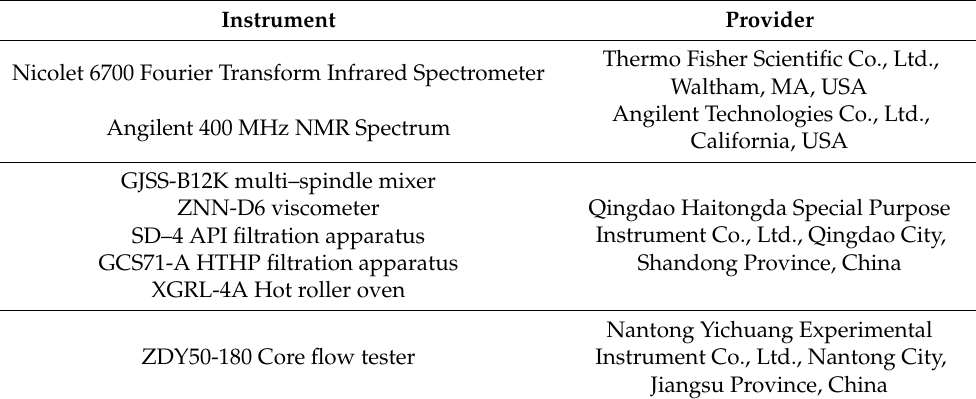
Table 1. Experiment instruments and the providers. Instrument Provider Nicolet 6700 Fourier Transform Infrared